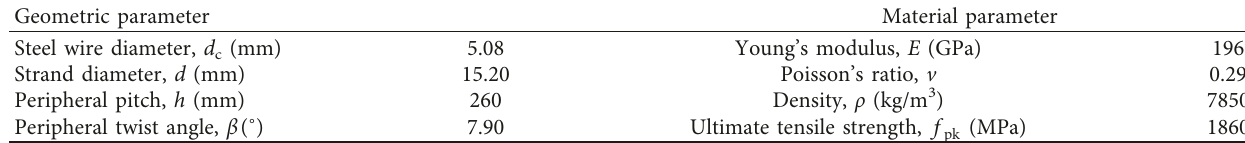
Table 1: Geometric and material parameters of steel strands.